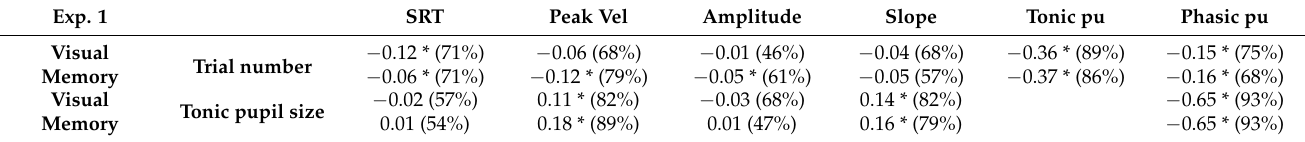
Table 1. Summary for the mean correlation coefficient values for each correlational analysis in Experiment 1 ( n = 28). * indicates statistically significant. Numbers in the bracket indicates the percentage of participants showing the same sign of correlation. SRT: saccade reaction time. Peak Vel: saccade peak velocity. Amplitude: saccade amplitude. Slope: the main sequence slope (peak velocity/amplitude). Tonic pu: tonic pupil size. Phasic pu: phasic pupil constriction. Visual: visually guided saccade task. Memory: memory-guided saccade